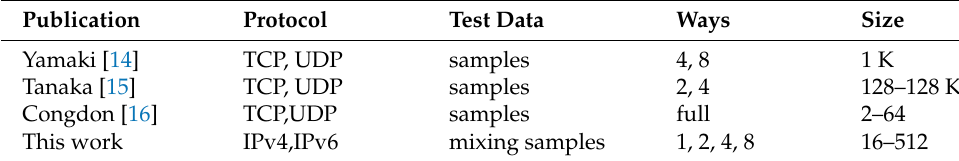
Table 2. Summary of the related